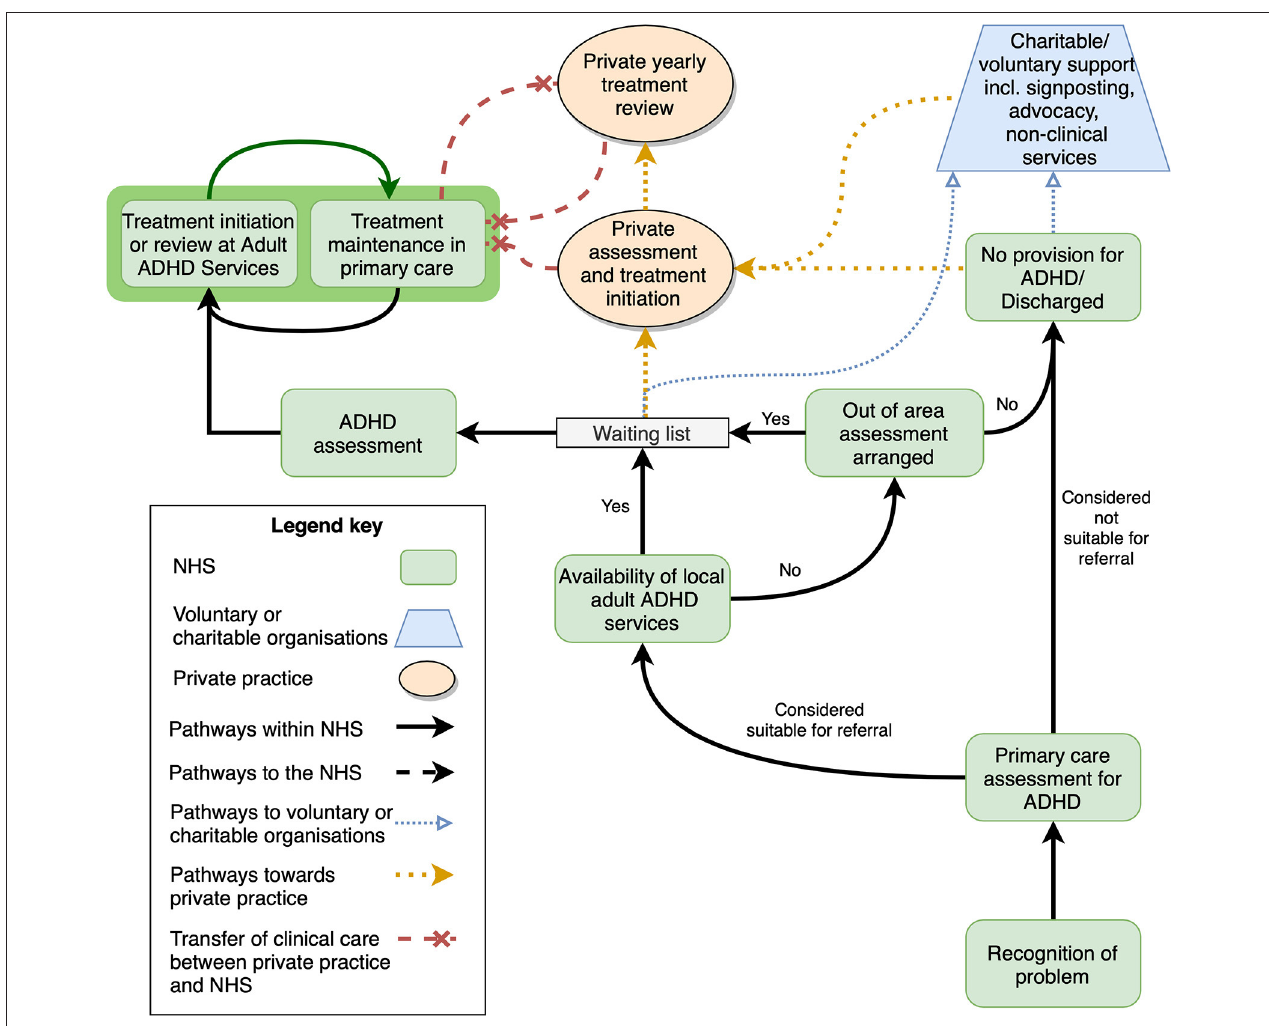
FIGURE 1 | Successful and unsuccessful pathways to Adult ADHD treatment initiation and maintenance. This simplified schema shows the interaction between NHS bodies and services, voluntary and charitable organizations, and private health services. Shared care arrangements are shown on a dark green background. Note that in the experience of the consensus group, shared care between NHS and private practices (red dashed line) are infrequently supported. NHS, national health services; ADHD, attention-deficit/hyperactivity